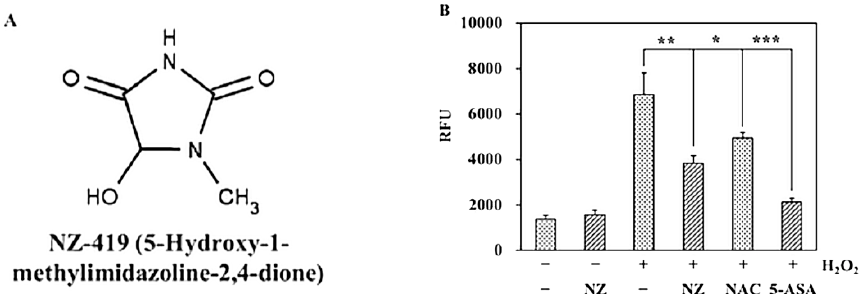
Figure 1. NZ-419 eliminates reactive oxygen species (ROS) production in HCT116 cells. ( A ) Chemical structure of NZ-419. ( B ) HCT116 cells were treated with 1 mM NZ-419 (NZ), 5 mM N -Acetyl- l -cysteine (NAC), 100 µ M 5-aminosalicylic acid (5-ASA) for 30 min and then treated with 0.5 mM H 2 O 2 and further incubated for 10 min to evaluate the amount of ROS production. NAC and 5-ASA are positive controls. Data are presented as the means ± SD ( n = 3). Asterisks indicate significant di ff erence from the untreated control group at * p < 0.05, ** p < 0.01, and *** p < 0.005. The data are representative